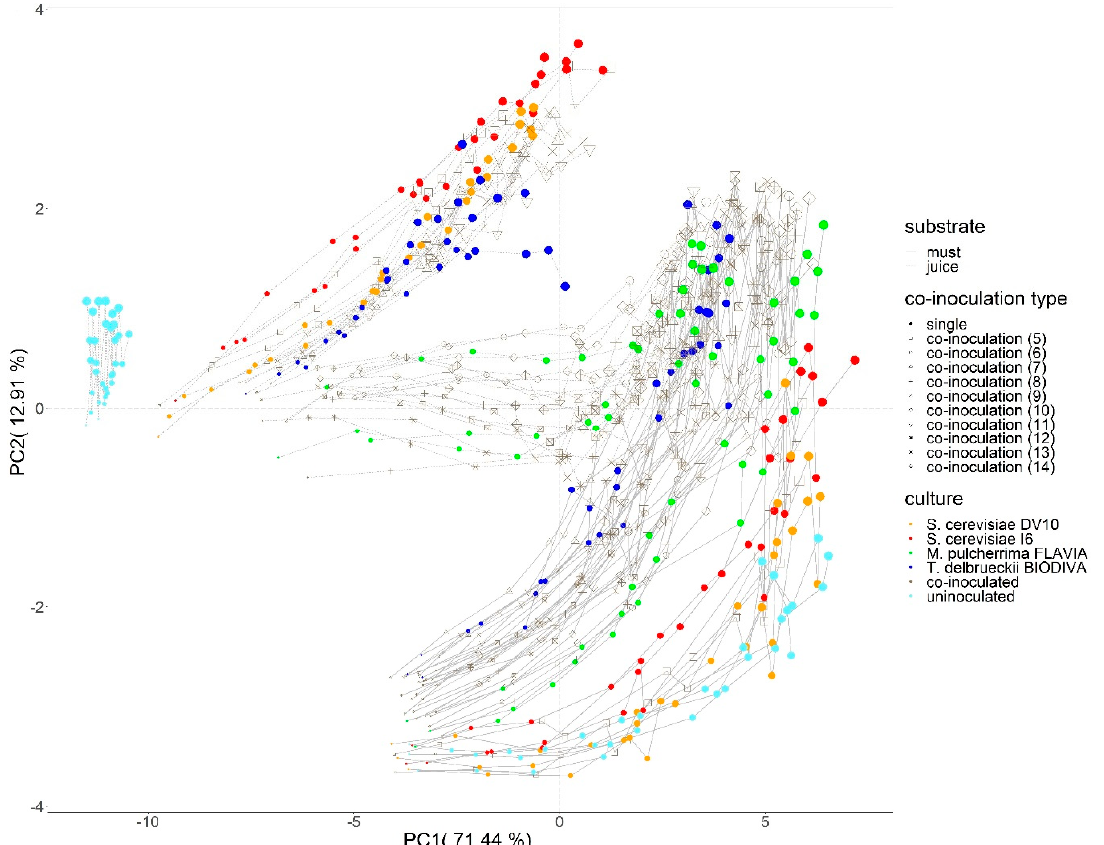
Figure 2. Score plot of the principal component analysis of volatile organic compound (VOC) emission evolution associated with the first three days of AF for each trial tested in this study. Data were logarithmically transformed and centered. Di ff erent colors indicate the di ff erent yeast managements, medium, and blank samples. The size of the points grew with the time of measurements. For a detailed view of the figure, the original image is included in the Supplementary Materials (Figure